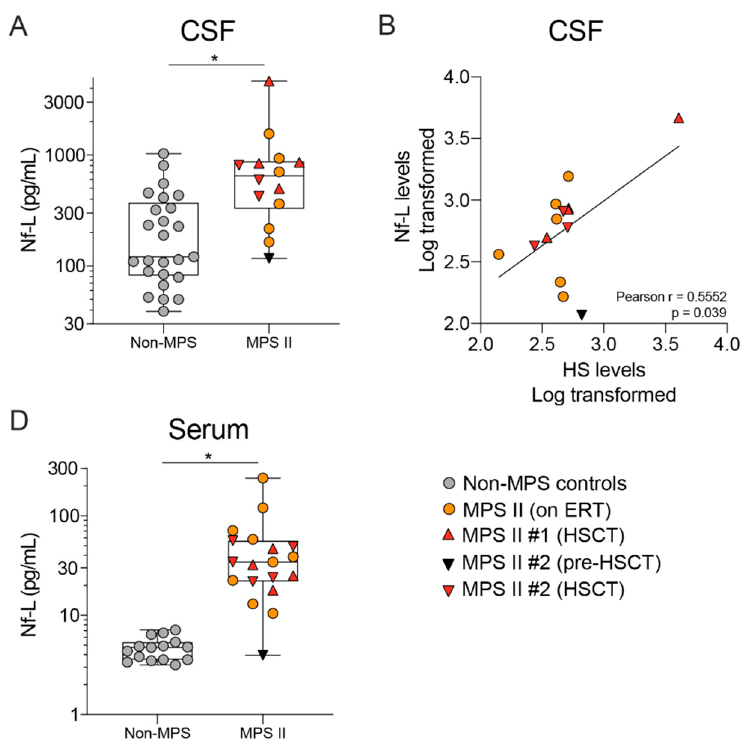
Figure 8. Neurofilament Light Chain (Nf-L) levels are elevated in the CSF and serum of nMPS II patients. Nf-L was quantified using SIMOA detection; ( A , B ) CSF Nf-L levels in nMPS II patients that were either untreated at the time of sample collection ( n = 1), on ERT ( n = 6), or on HSCT ( n = 2) were compared to age-matched controls ( n = 25); ( C , D ) Serum HS and DS levels in nMPS II patients who were either untreated at the time of sample collection ( n = 1), on ERT ( n = 9), or on HSCT ( n = 2) were compared to age-matched controls ( n = 15). Each data point represents a single control or patient visit. Data are plotted using a min to max box plot. Differences between nMPS II and non-MPS controls are estimated using a linear mixed-effects model to account for repeated measures in 2 patients. Age was adjusted as a linear effect, and treatment effects are not considered due to the small sample set ( n = 2 for HSCT), and thus the model will not specifically adjust for this in the estimation; * p < 0.05.